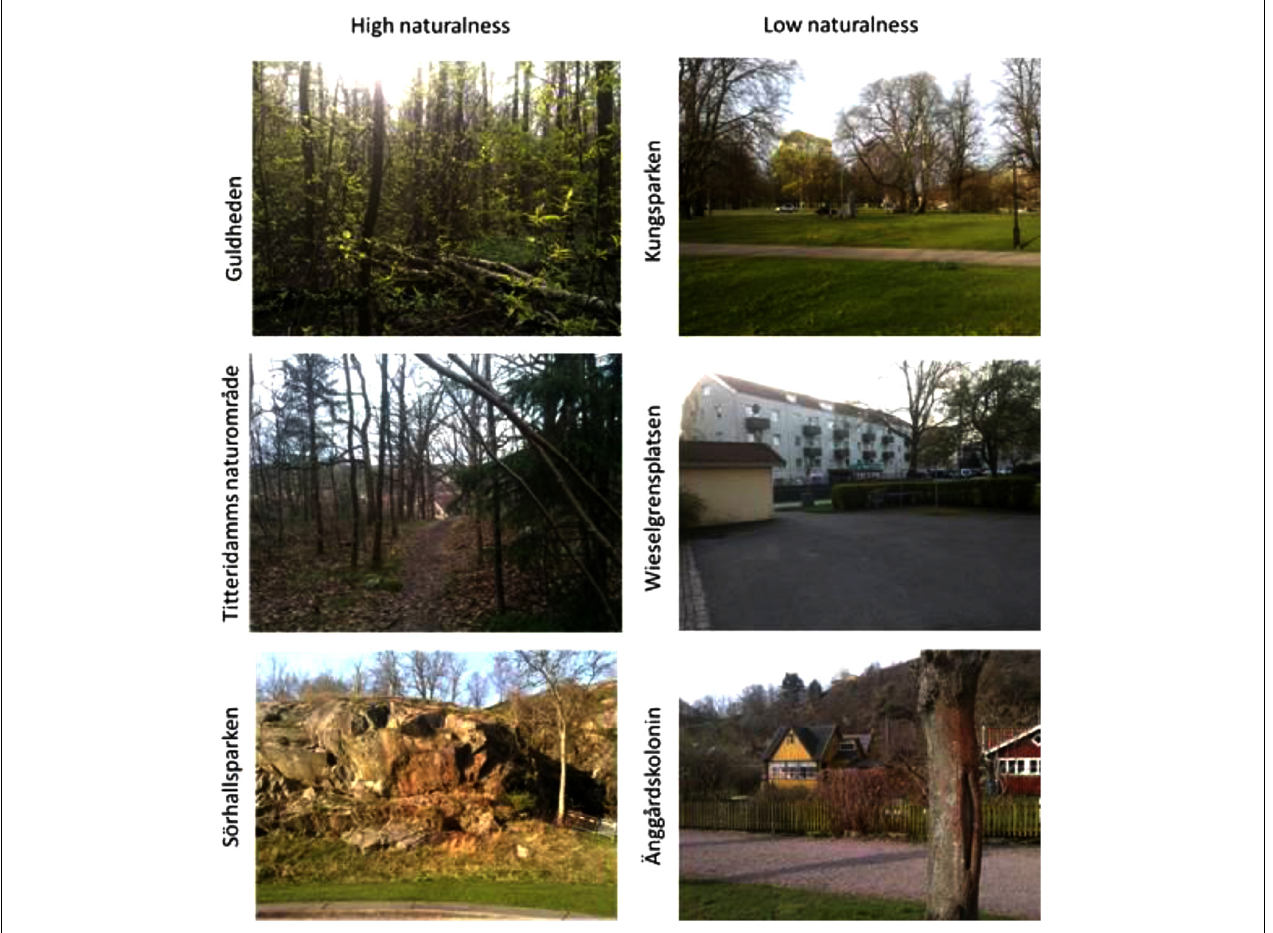
FIGURE 1 | Photos (by Erik Heyman) of the six different settings (from a previous open access publication, Hedblom et al., 2017) representing high vs. low